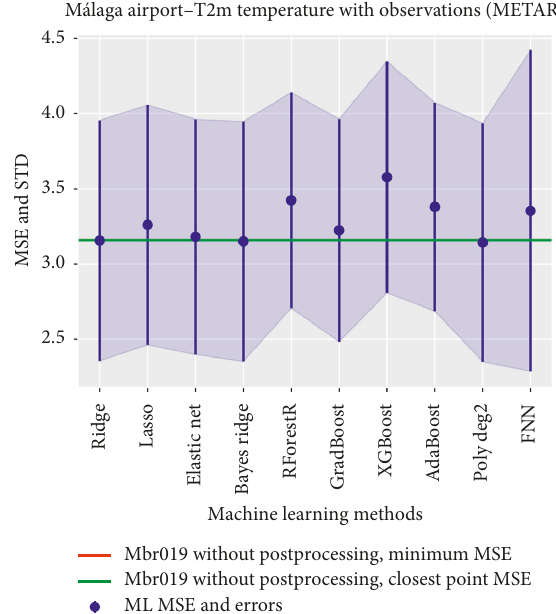
Figure 5: T2m calibration plot for Palma airport. Horizontal axis as in Figure 3.